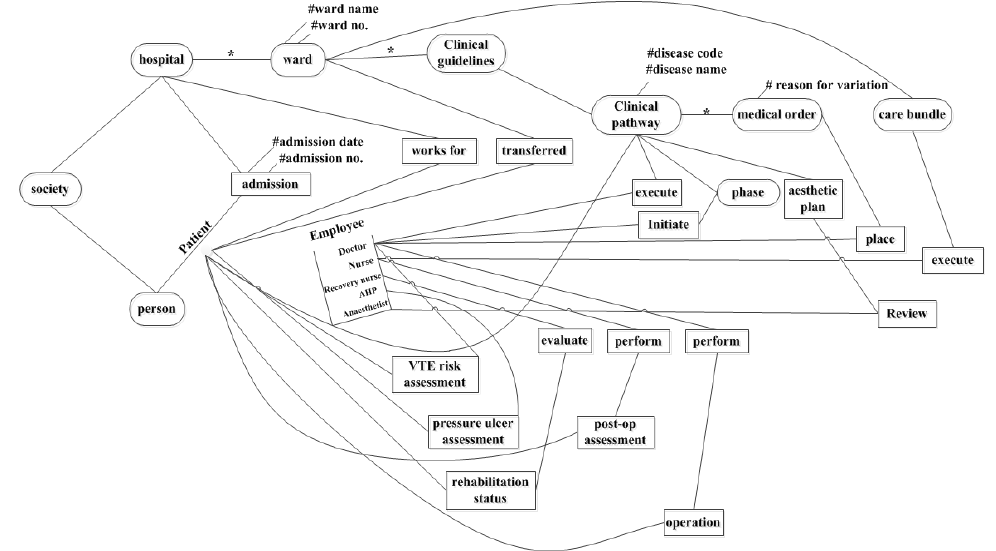
Figure 1. Ontology chart representing major gynecology care